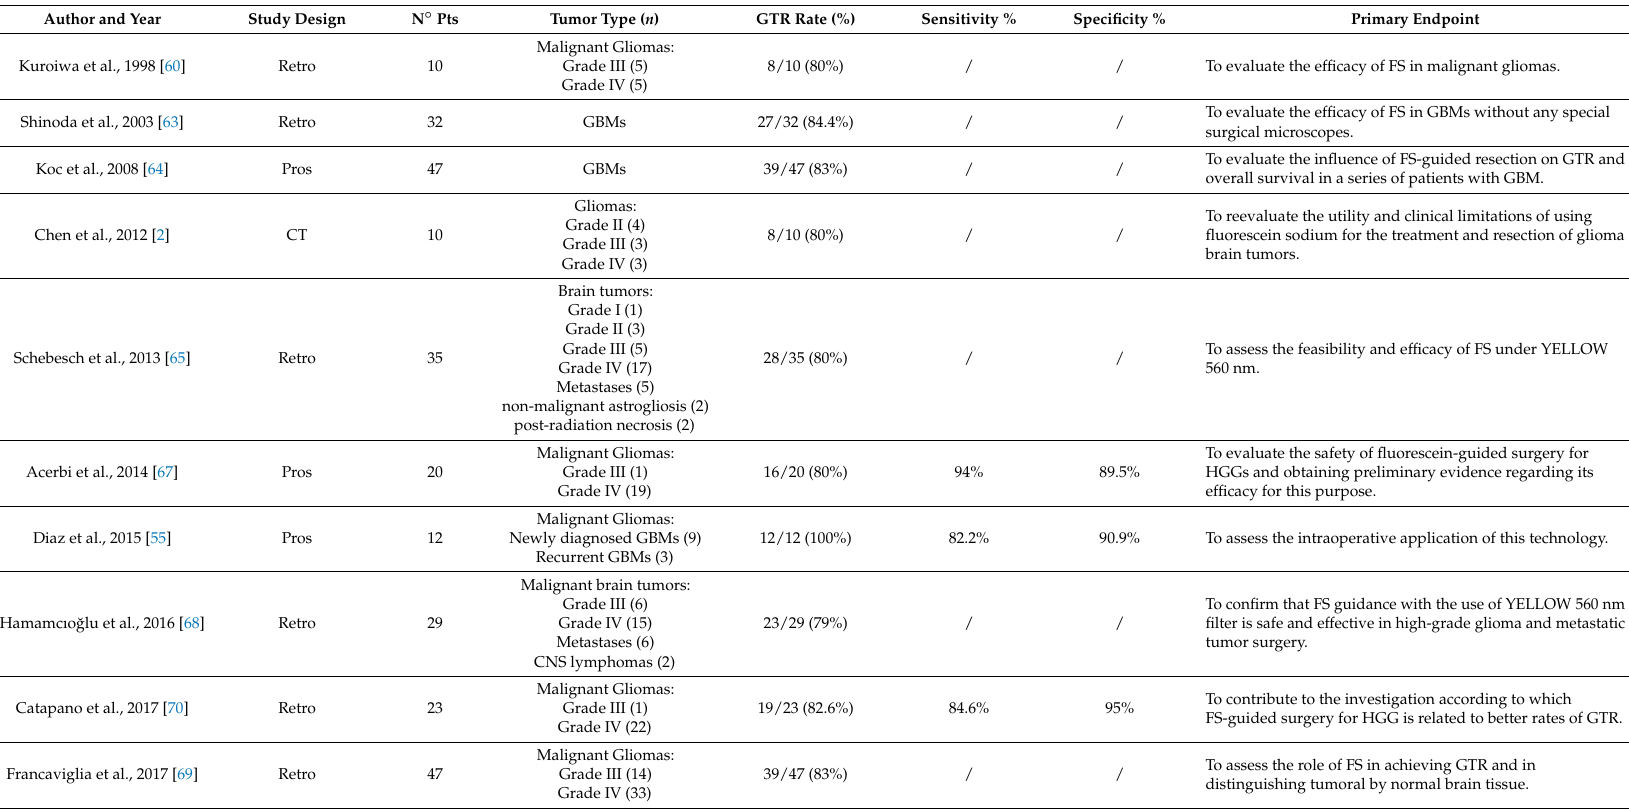
Table 2. Clinical series of patients with gliomas treated with a fluorescein sodium aided surgery. Literature